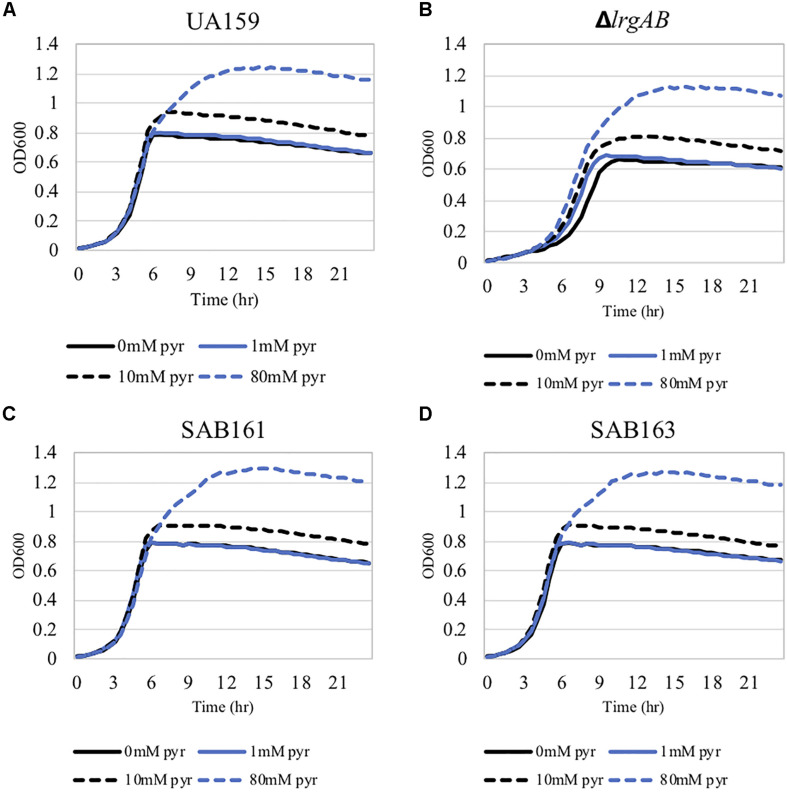
The effect of exogenously added pyruvate on the aerobic growth of the lrg-derivative strains. The strains, including S. mutans UA159 (WT, A), ΔlrgAB (lrgAB-deficient, B), SAB161 (lrgAB-overexpressing, C), and SAB163 (lytST-overexpressing, D) in BHI medium supplemented by different concentrations of exogenous pyruvate (0, 1, 10, and 40 mM). OD600 was monitored every 30 min at 37°C using the Bioscreen C lab system. The results are representative of three independent experiments.